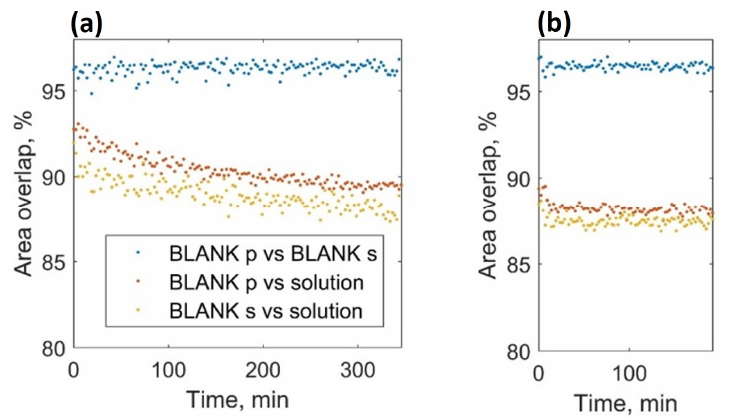
Figure 3. Time course of area overlap between the spectrum of Lys adsorbed to the blank crystal and spectrum of Lys in solution during adsorption ( a ) and desorption ( b ).